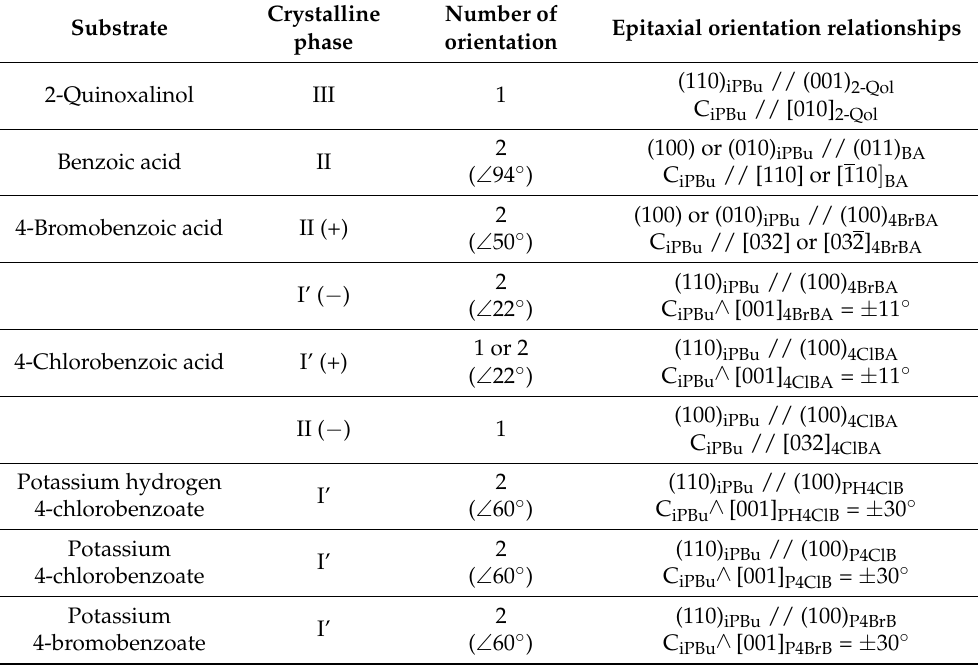
Table 1. The epitaxial relationship of iPBu on different substrates in different phases